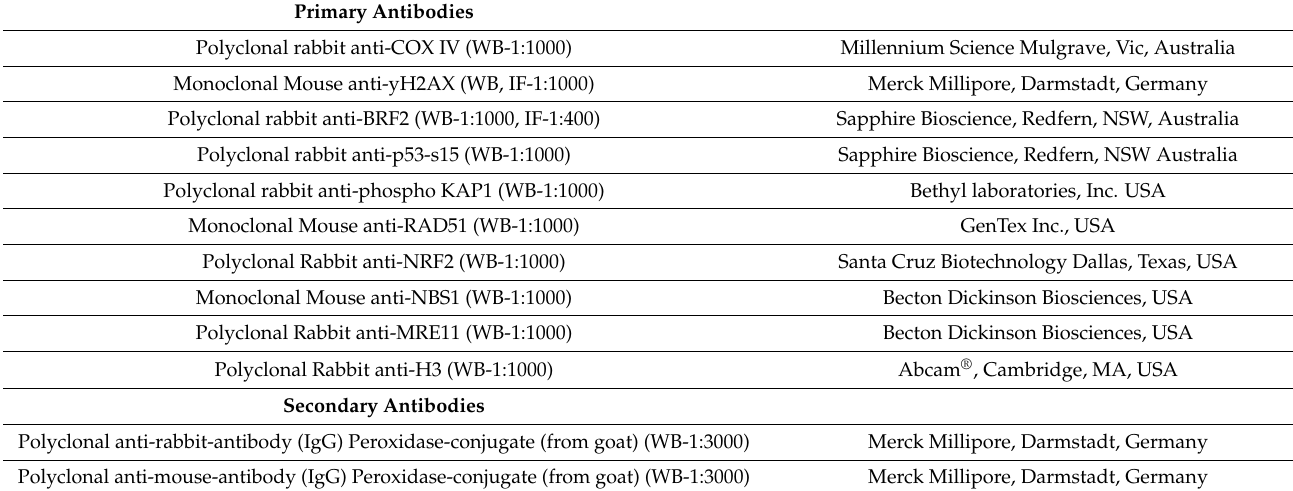
Table 1. List of antibodies used in this